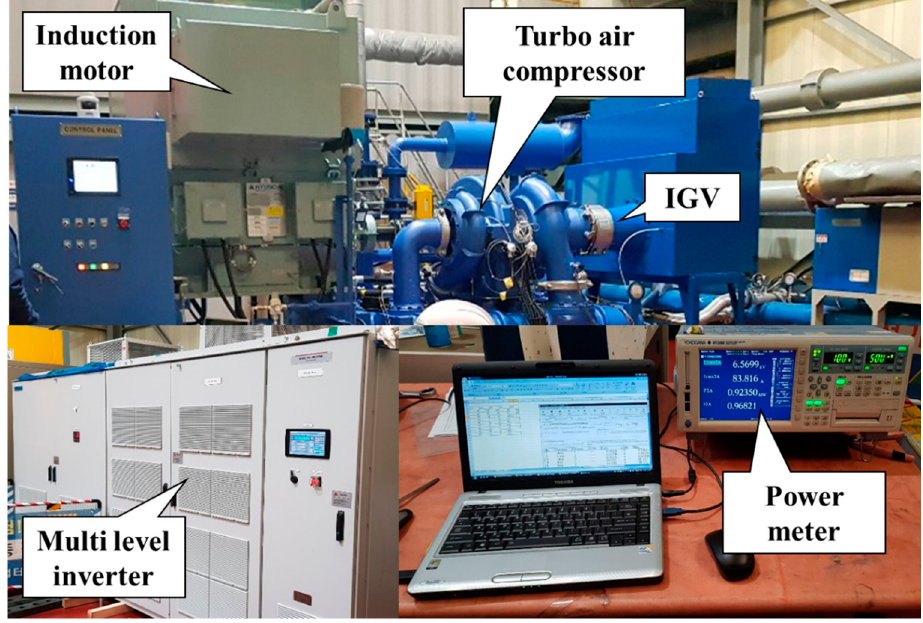
Figure 8. Experimental setup for